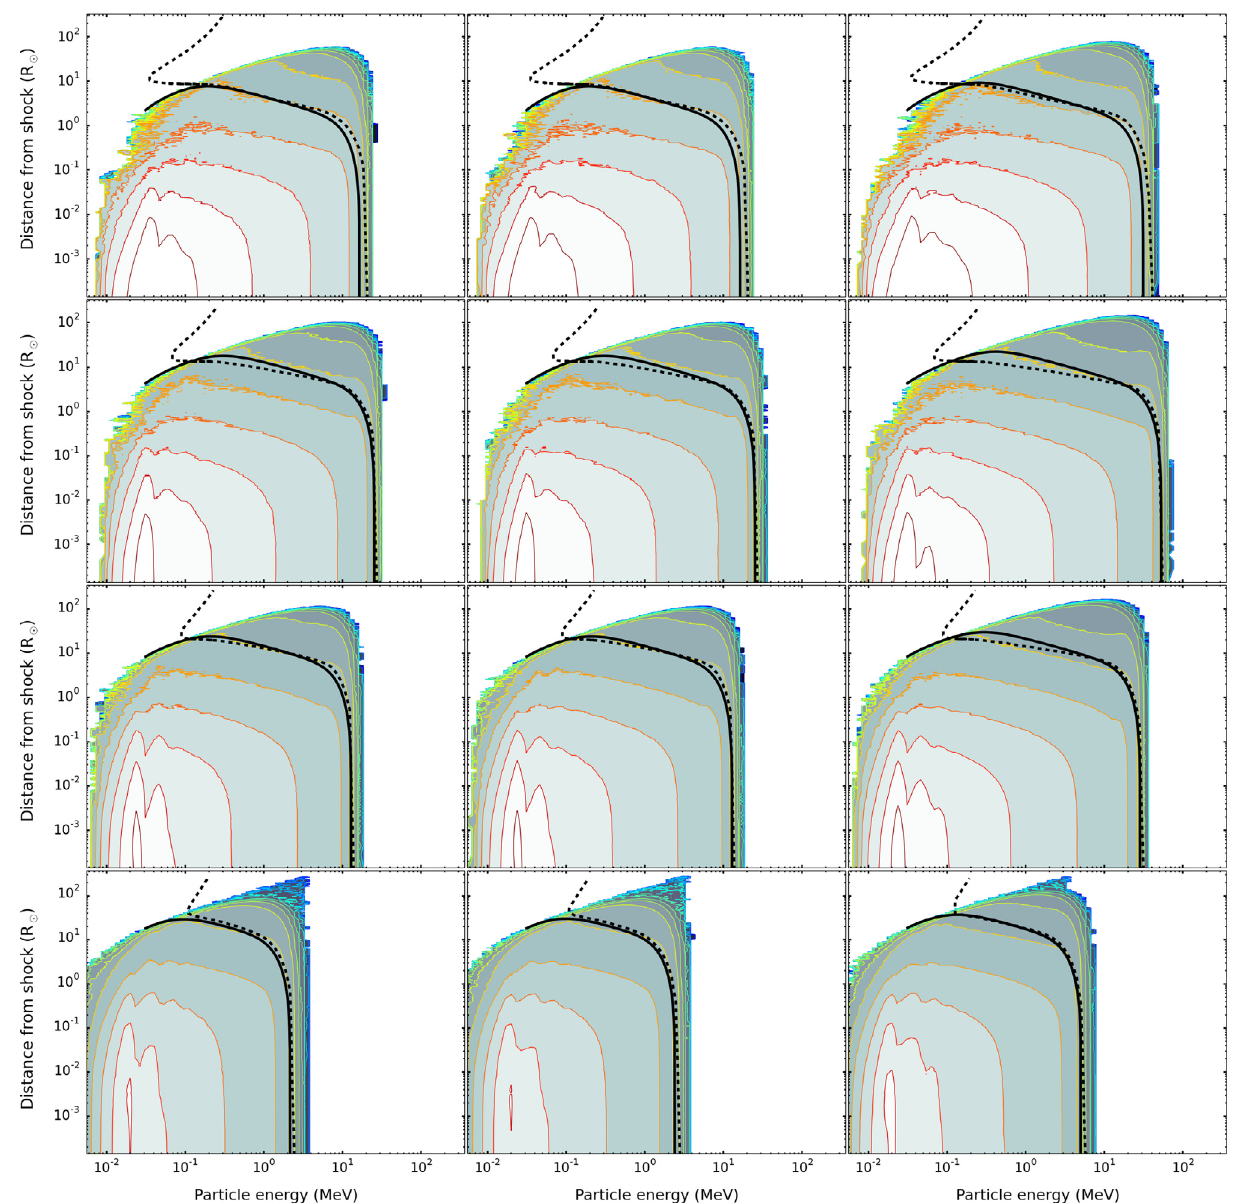
Fig. 6. The location of the foreshock boundary as obtained from the semi-analytical model (solid curves) compared with the location obtained from each simulation (dashed curve). The three adjacent panels present the comparison for the runs 1a, 1b and 1c (top row) to runs 4a, 4b and 4c (bottom row). The colour scale is the same as in Figure